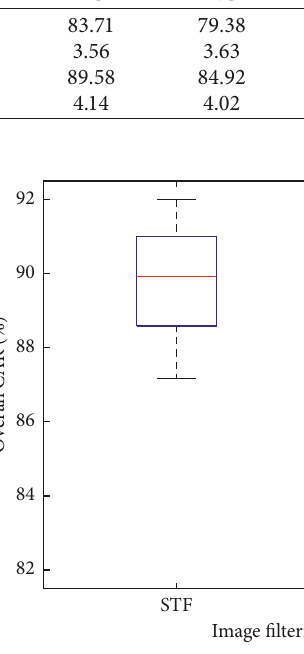
Figure 12: Box plots of prediction results of Adaboost CTree-SBF and Adaboost